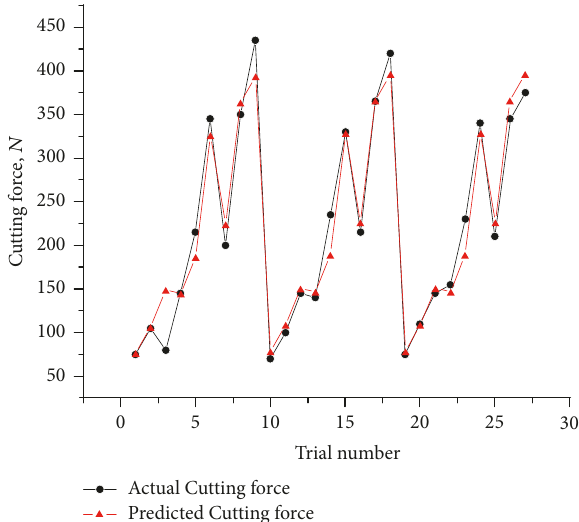
Figure 6: Actual and predicted values of cutting force.